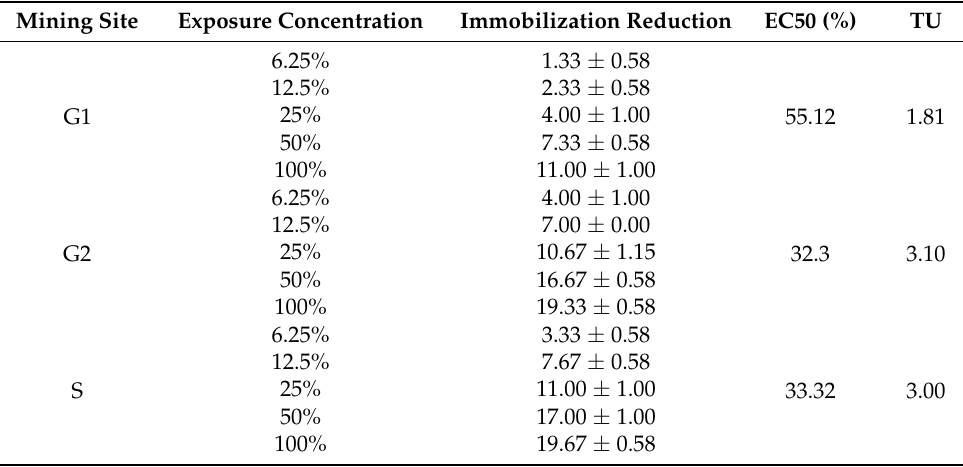
Table 3. The bioassay test using D. magna by field water exposure. Mining Site Exposure